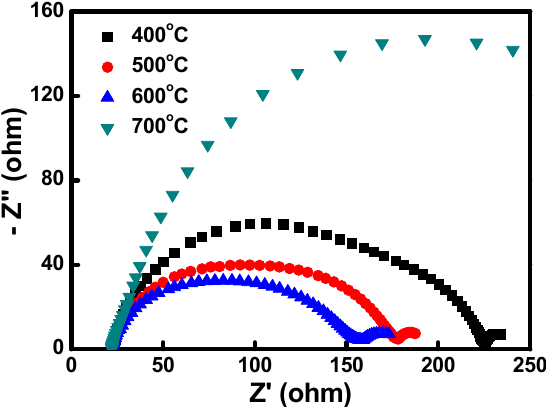
Figure 8. Electrochemical impedance spectra of symmetrical device structures fabricated using the Cu 2 O CEs sintered at various temperatures.